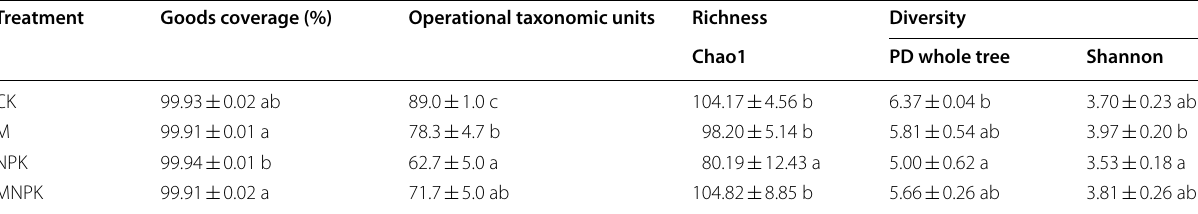
Values within the same column followed by different letters indicate significant differences ( P < 0.05) according to Tukey’s multiple comparison